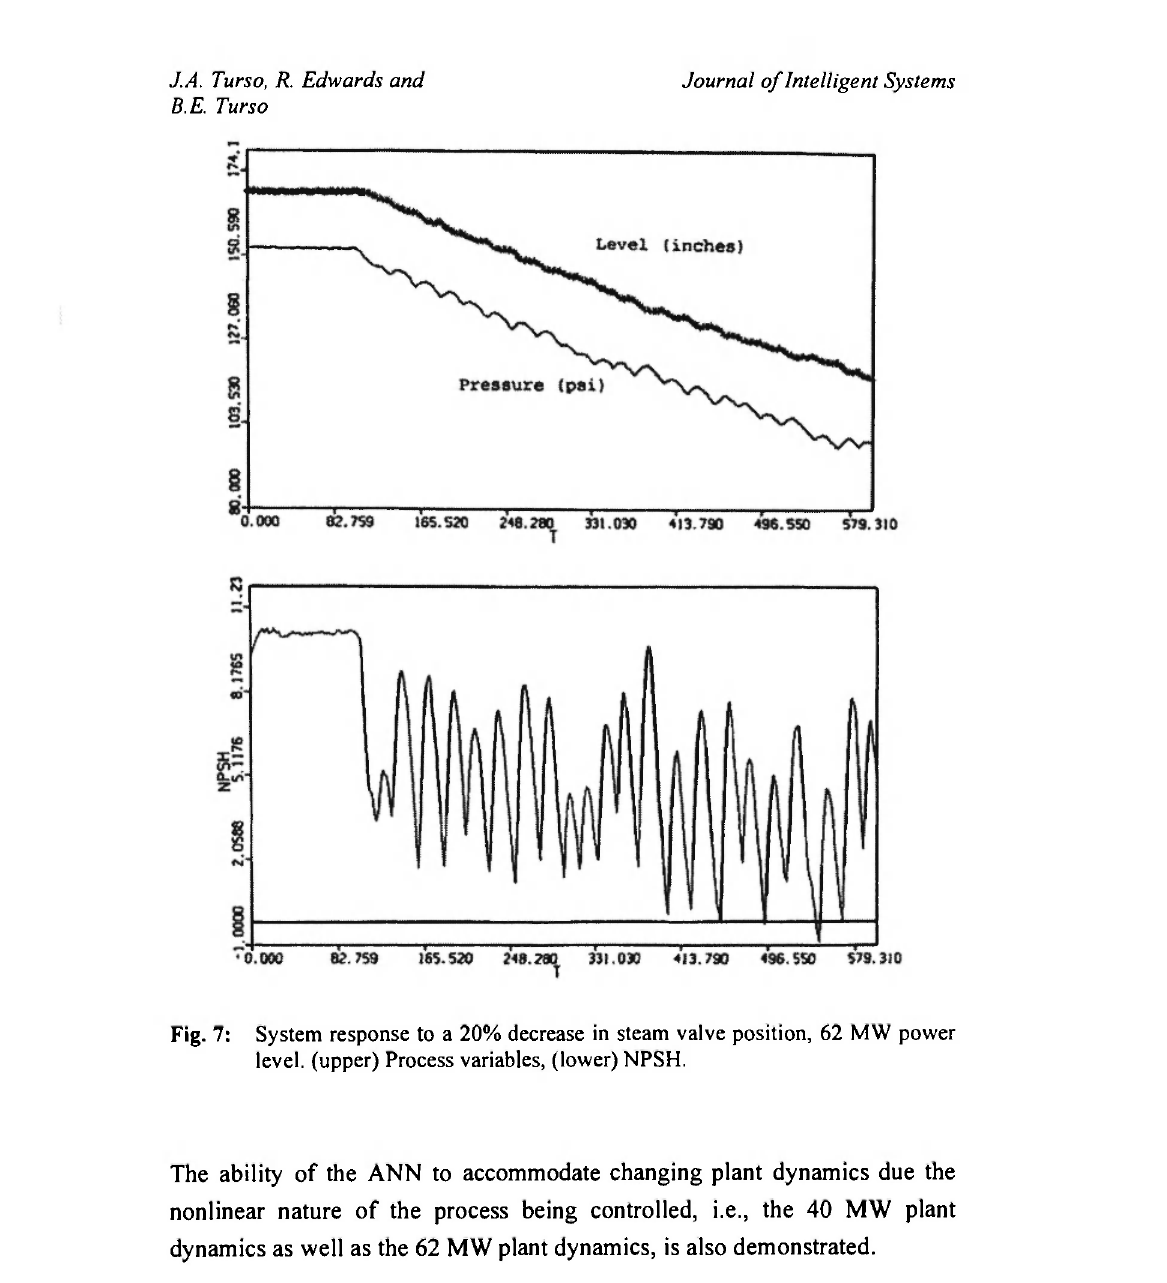
Fig. 7: System response to a 20% decrease in steam valve position, 62 MW power level, (upper) Process variables, (lower)